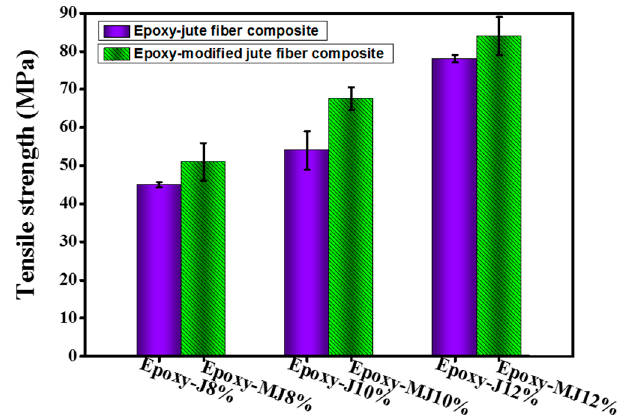
Figure 4. E ff ect of fiber loading on the tensile strengths of the modified Figure 4. Effect of fiber loading on the tensile strengths of the modified composites.